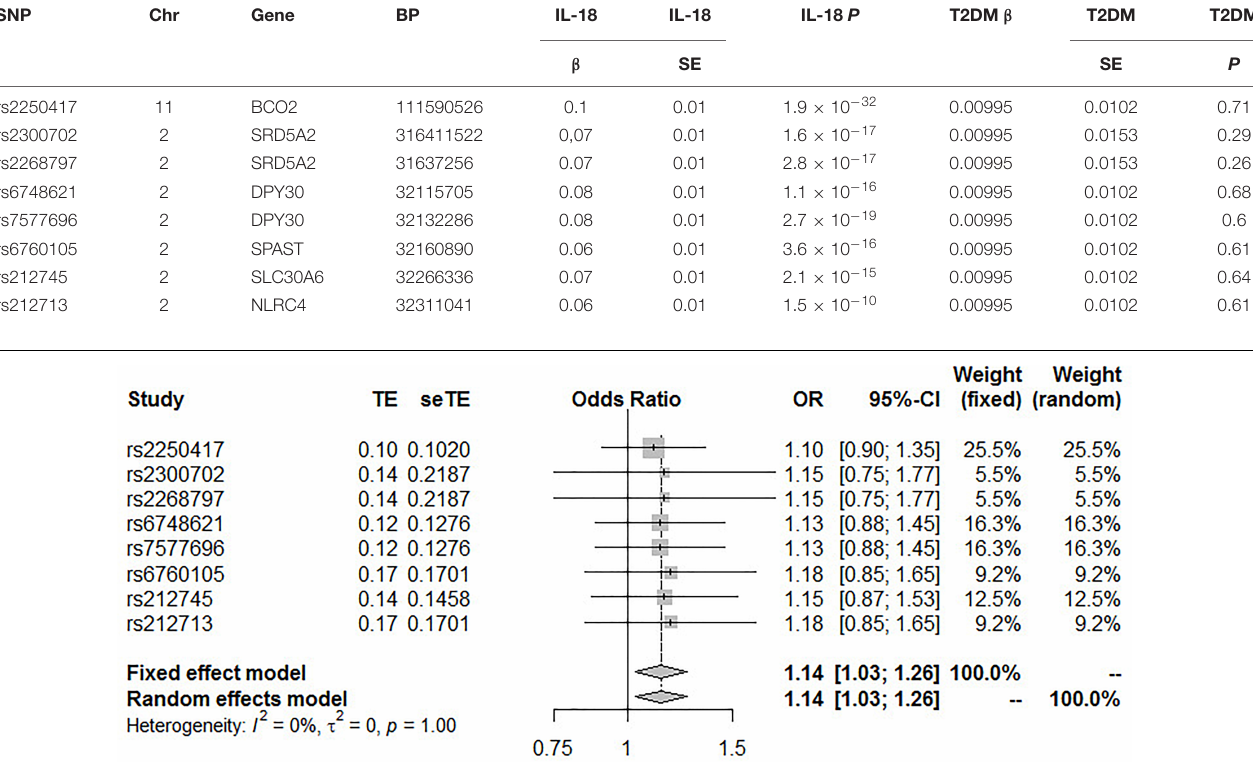
TABLE 1 | Associations of genetic variants with IL-18 and T2DM.